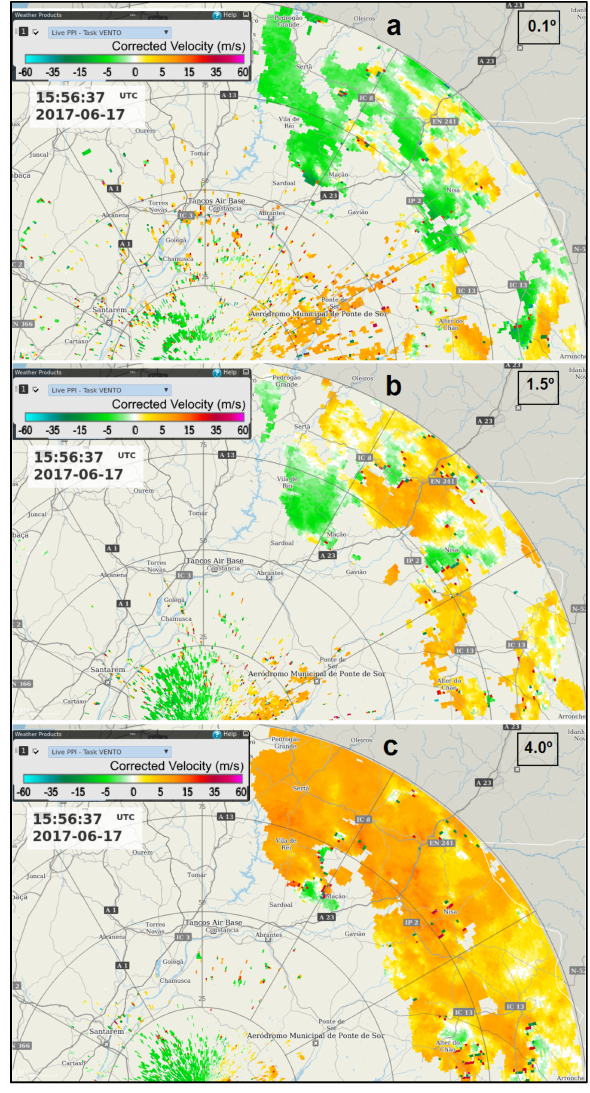
Figure 10. PPI of the storm-relative velocity, 0.1 ◦ tilt ( a ), 1.5 ◦ tilt ( b ) and 4.0 ◦ tilt ( c ), 15:56 UTC, 17 June 2017, C/CL